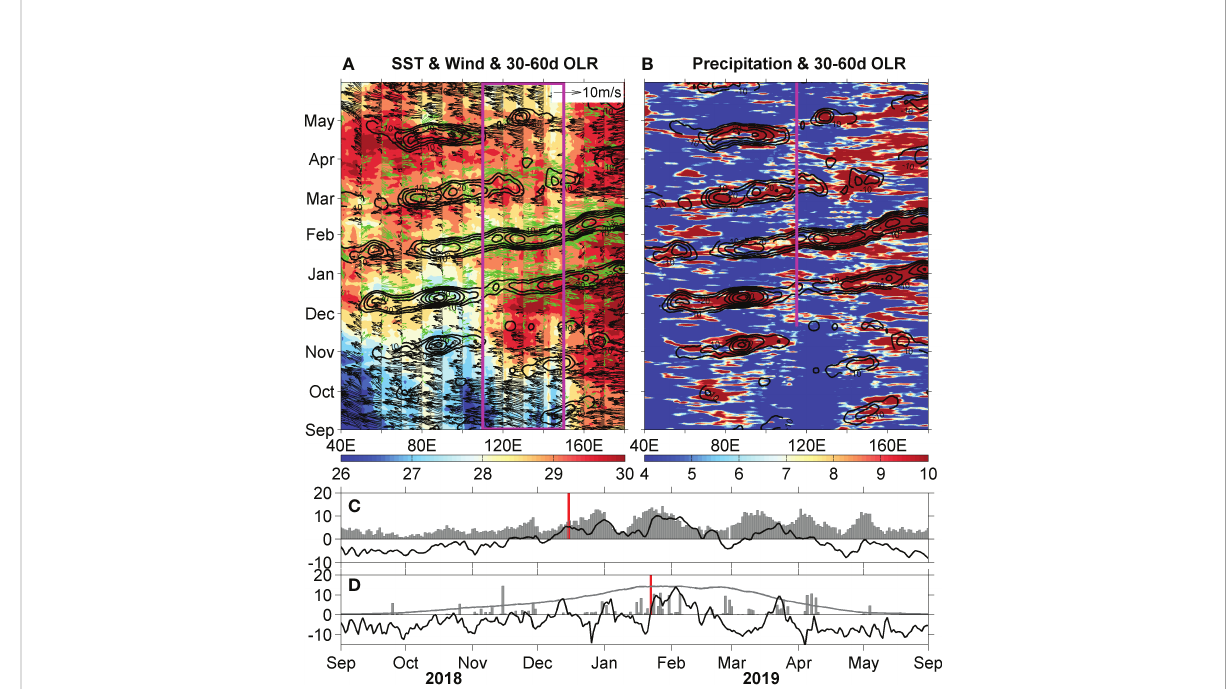
FIGURE 2 Longitude-time diagram of the meridionally averaged (A) SST (shaded; °C), wind fi eld (vectors; m s − 1 ), 30 – 60-day bandpass- fi ltered OLR anomaly (contours; W m − 2 ; only values lower than − 10 W m − 2 are plotted), and (B) precipitation (shaded; mm day − 1 ) and repeated 30 – 60-day OLR anomaly (contours) from September 2018 to May 2019, all averaged between 15°S and 0°. The magenta box in (A) indicates the IASM region. The green (black) vectors in (A) mean that the zonal winds are westward (eastward). The thin magenta line in (B) denotes the position and available observation period of the moored buoy. Time series of (C) the daily area-averaged zonal wind (black line; m s − 1 ) and precipitation (gray bars; mm day − 1 ) over the IASM region and (D) the zonal wind (black line; m s − 1 ), precipitation (gray bars; mm day − 1 , reduced by a factor of 5), and climatological daily mean precipitation (gray line) at Darwin airport station. The thick red bar indicates the onset date of the 2018/2019 IASM de fi ned in the present study (C) and that of fi cially declared by the Australian Bureau of Meteorology (D)